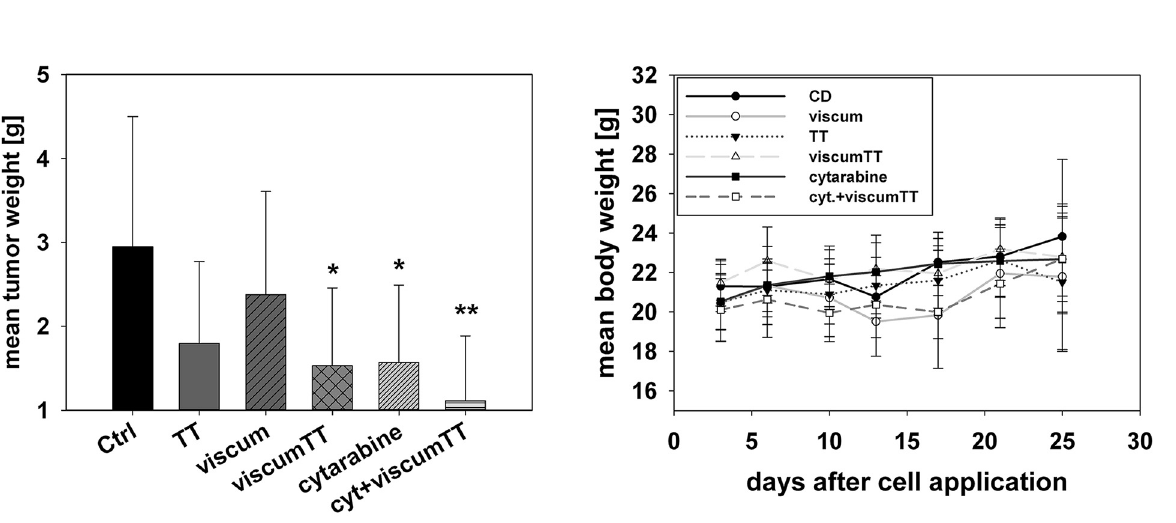
Fig 6. In vivo efficacy of Viscum album L. extracts. NOD/SCID/IL2rg mice carrying systemic human promyelotic leukaemia cells (HL-60) were treated with a dose-escalation regimen of 20/40/60/ mg/kg oleanolic acid (TT), 0.3/0.4/0.5 μ g/kg lectin (viscum) or a combination thereof (viscumTT), three times per week for two weeks post-transplantation of cells. Each concentration were given twice (i.v.), starting on day three after tumor cell injection. One group was treated with cytarabine and one with cytarabine plus viscumTT. Control mice received equal amounts of cyclodextrins. The treatment with viscumTT had a significant therapeutic advantage compared to the single extracts TT and